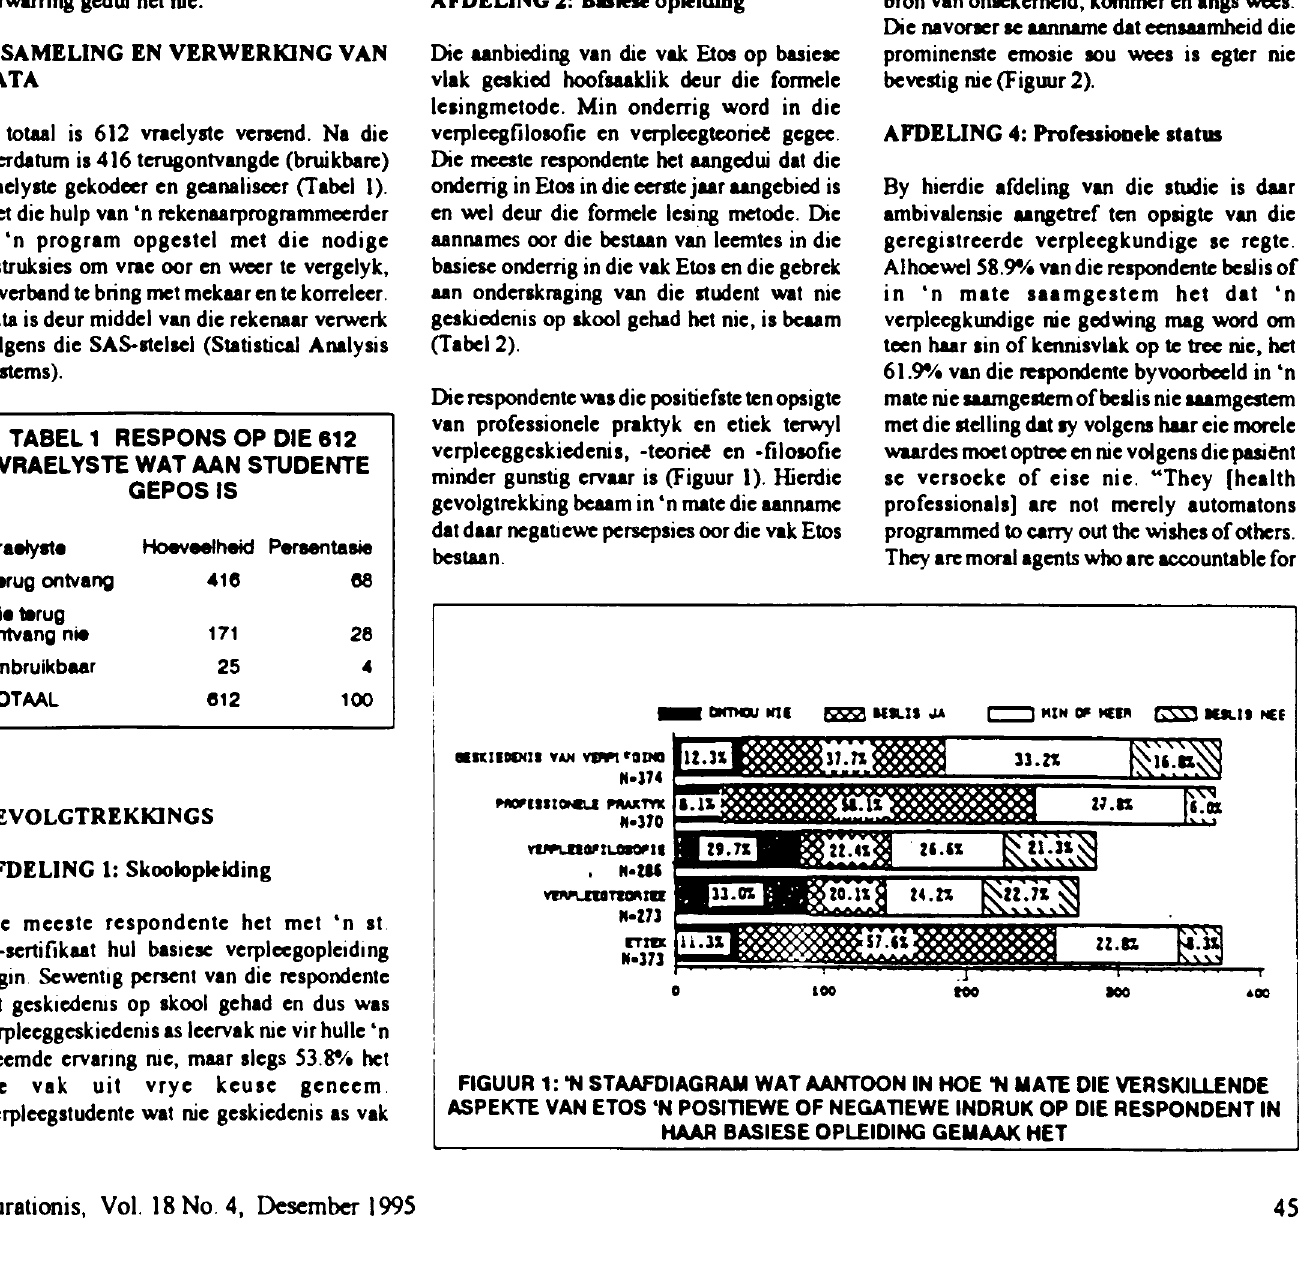
STAAFDIAGRAM WAT AANTOON IN HOE -N MATE DIE VERSKILLENDE ASPEKTE VAN ETOS ‘N POSIT1EWE OF NEGATIEWE INDRUK OP DIE RESPONDENT IN HAAR BASIESE OPLEIDING GEMAAK